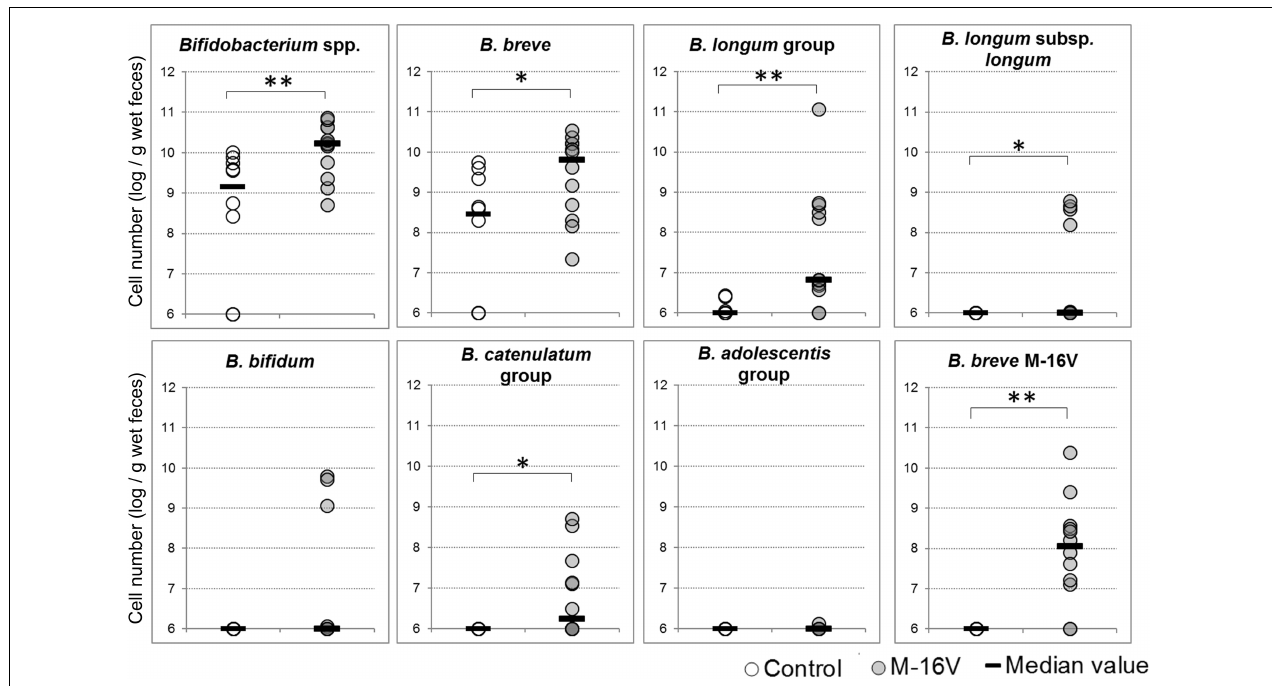
FIGURE 4 | Quantitative PCR detection of Bifidobacterium species and B. breve M-16V. Cell numbers were determined as the log 10 of cells per gram wet weight in each fecal sample. The detection limit was below 10 6 /g wet weight of feces. Intergroup differences were analyzed using the Mann-Whitney U -test. ∗ P < 0.05; ∗∗ P <